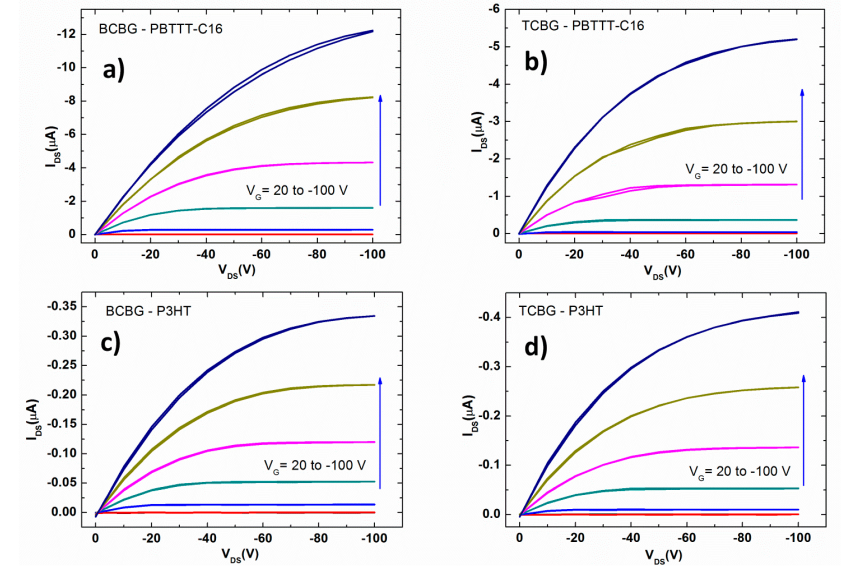
-V output characteristics under nitrogen flux of: Figure 3. Double current-voltage I DS DS using poly[2,5-bis(3-tetradecylthiophen-2-yl)thieno[3,2-b]thiophene] (PBTTT-C16) ( a ), BCBG ( b ), TCBG; and poly(3-hexylthiophene-2,5-diyl) (P3HT) ( c ) BCBG, ( d ) TCBG. Gate voltages go from +20 V to −100 V in steps of −20